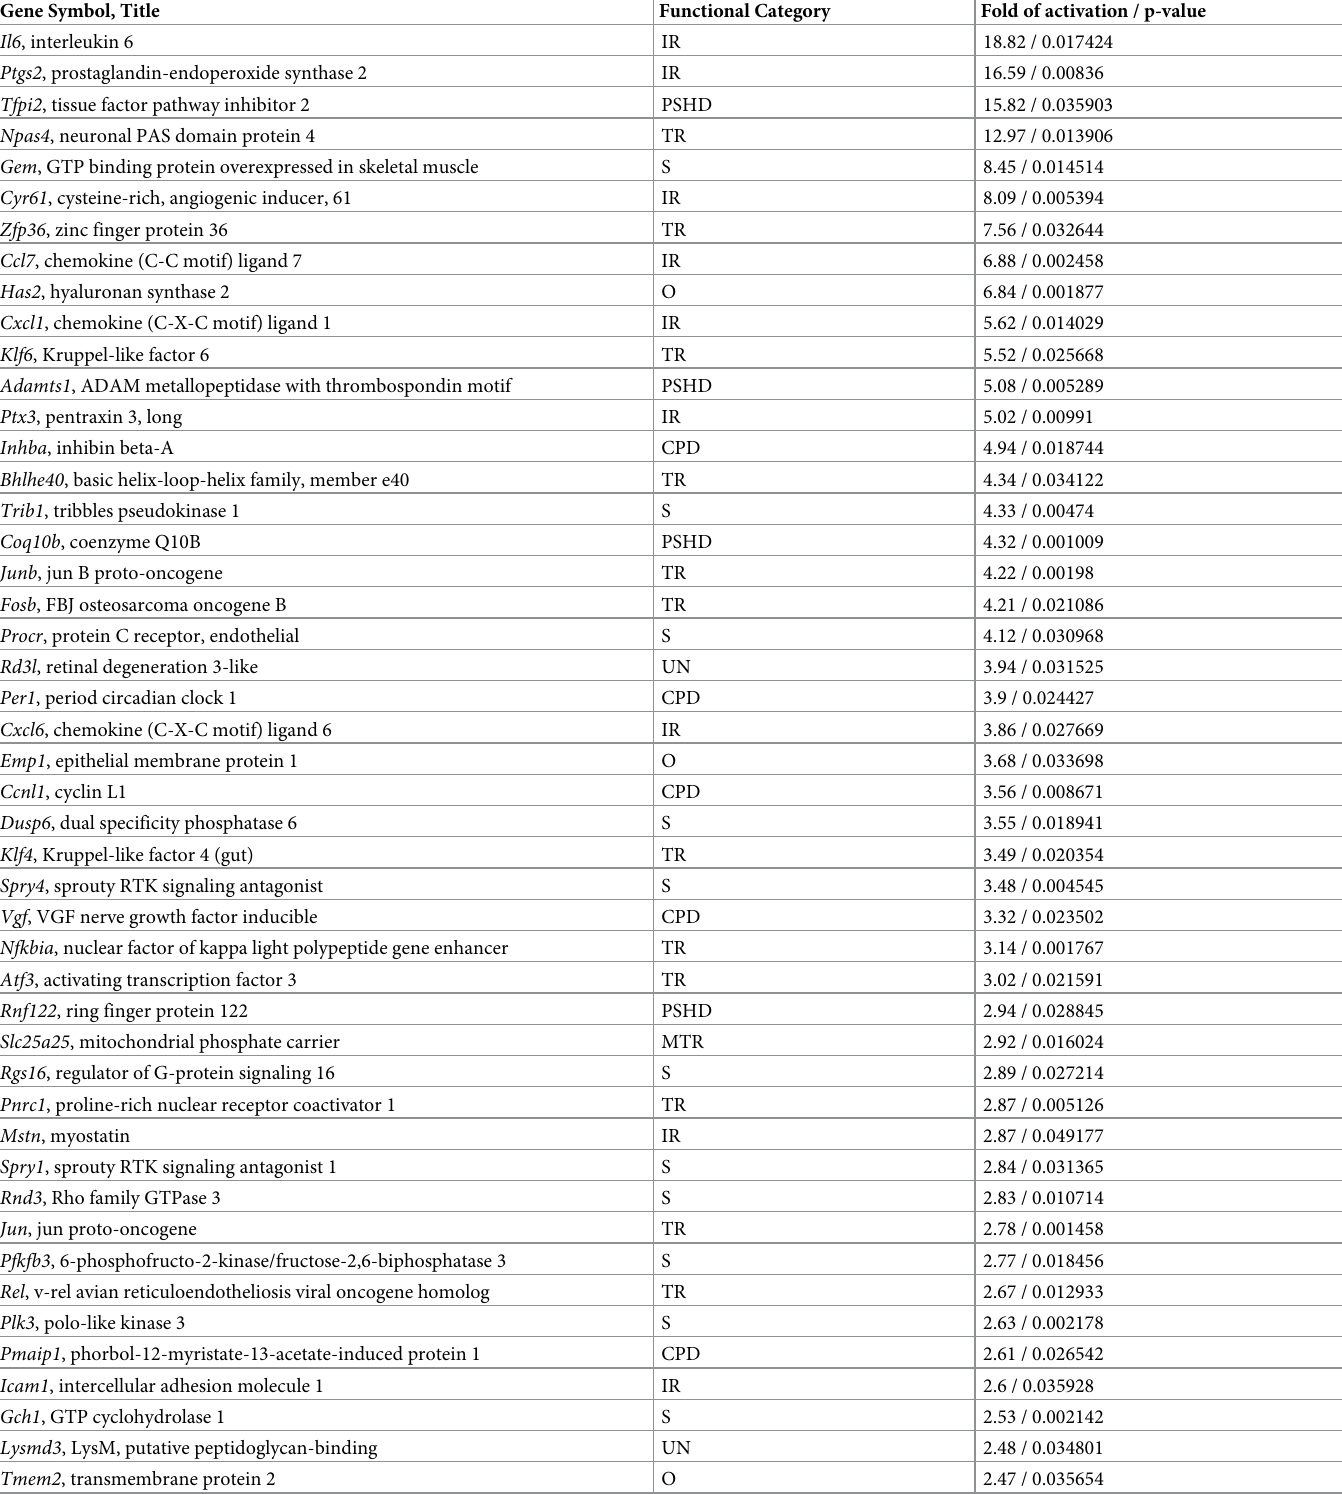
Table 6. Genes whose expression was increased by 1 mM ouabain by more than